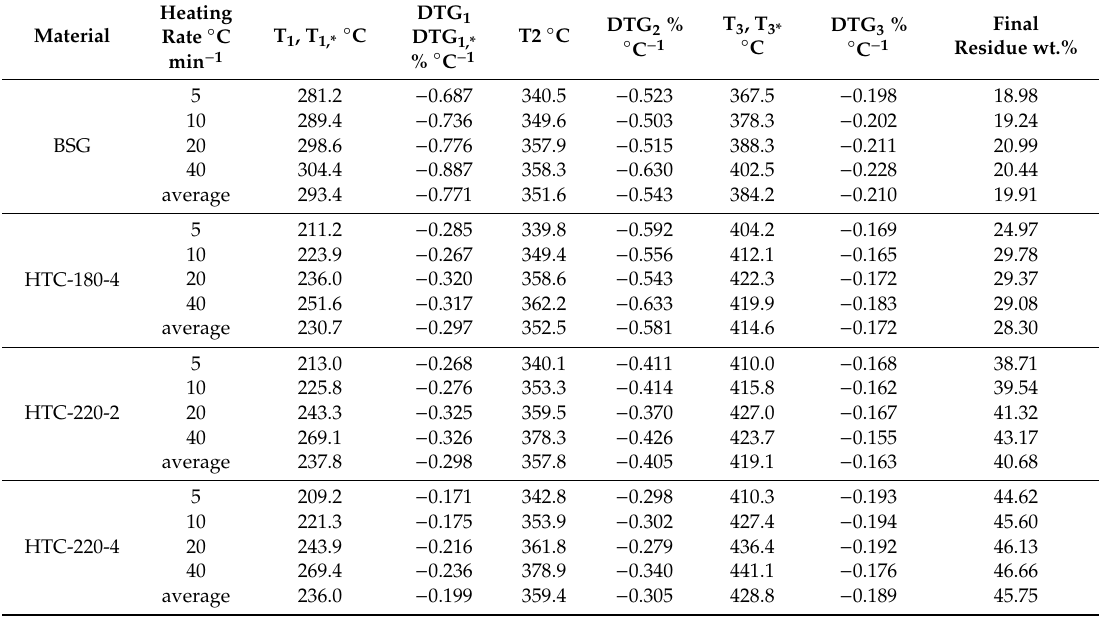
Table A1. Characteristic parameters during thermal decomposition of brewer’s spent grains and its hydrochars at di ff erent heating